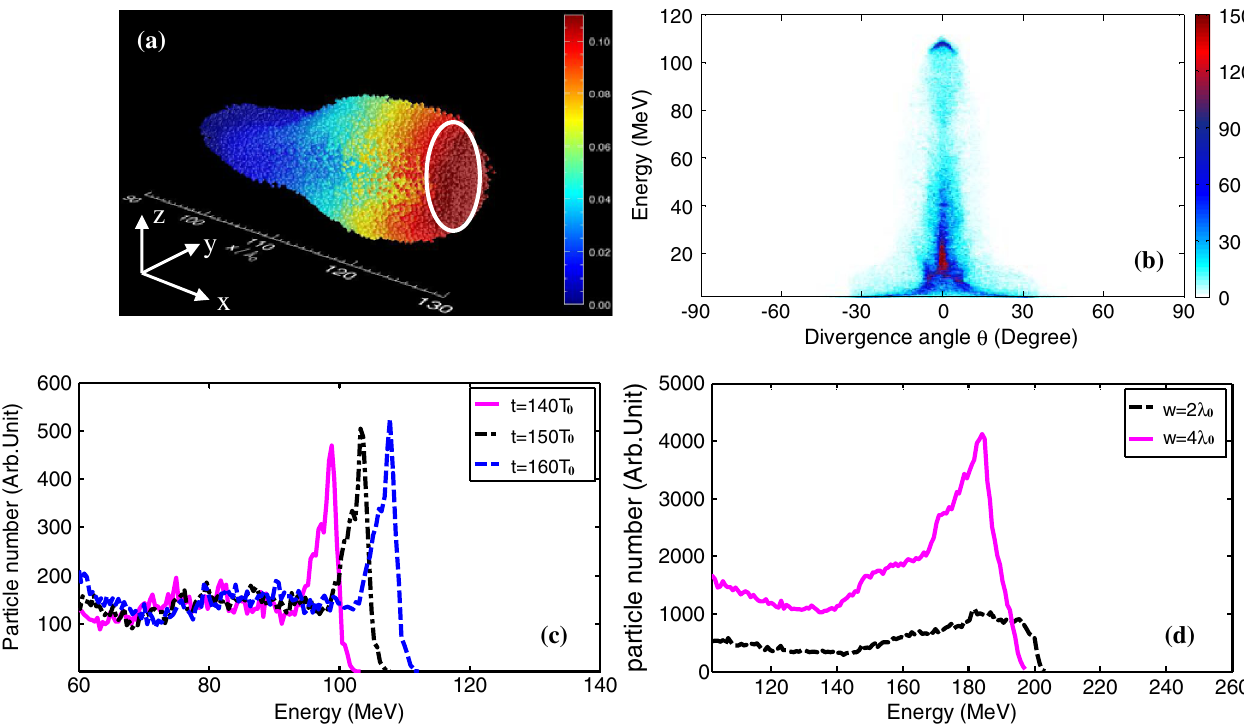
FIG. 5. 3D PIC simulation results. (a) Spatial and kinetic energy (normalized by m p c 2 ) distribution of the I-protons at t ¼ 160 T 0 . (b) Divergence angle and kinetic energy distribution of the I-protons at t ¼ 160 T 0 . (c) Evolution of the energy spectra of the high- energy I-proton peak for a ¼ 12 . (d) Comparison of the energy spectra of the high-energy part of the I-protons with its transverse size w ¼ 4 (cid:2) a ¼ 22 at t ¼ 160 T w ¼ 2 (cid:2) 0 (black dashed line) and 0 (pink solid line) obtained with the laser amplitude 0